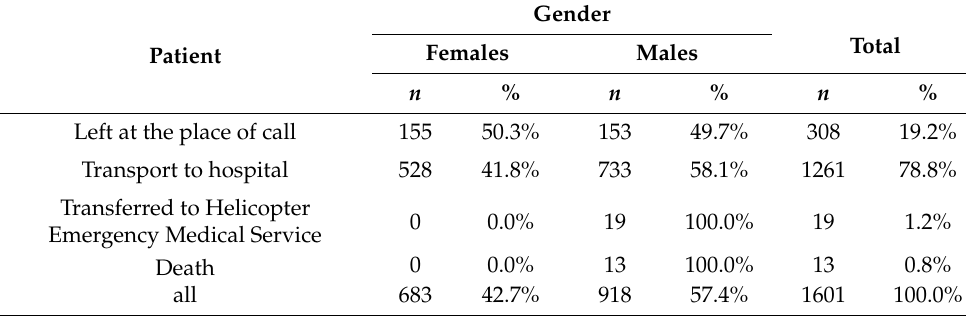
Table 5. Conclusions of interventions by emergency medical services teams in the workplace by gender.